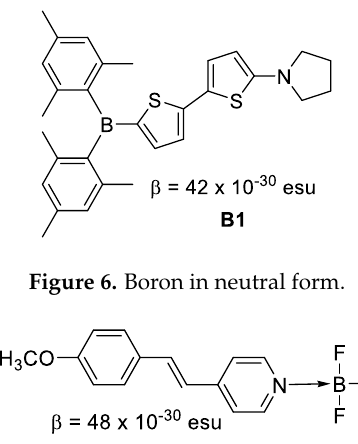
Figure 6. Boron in neutral form.